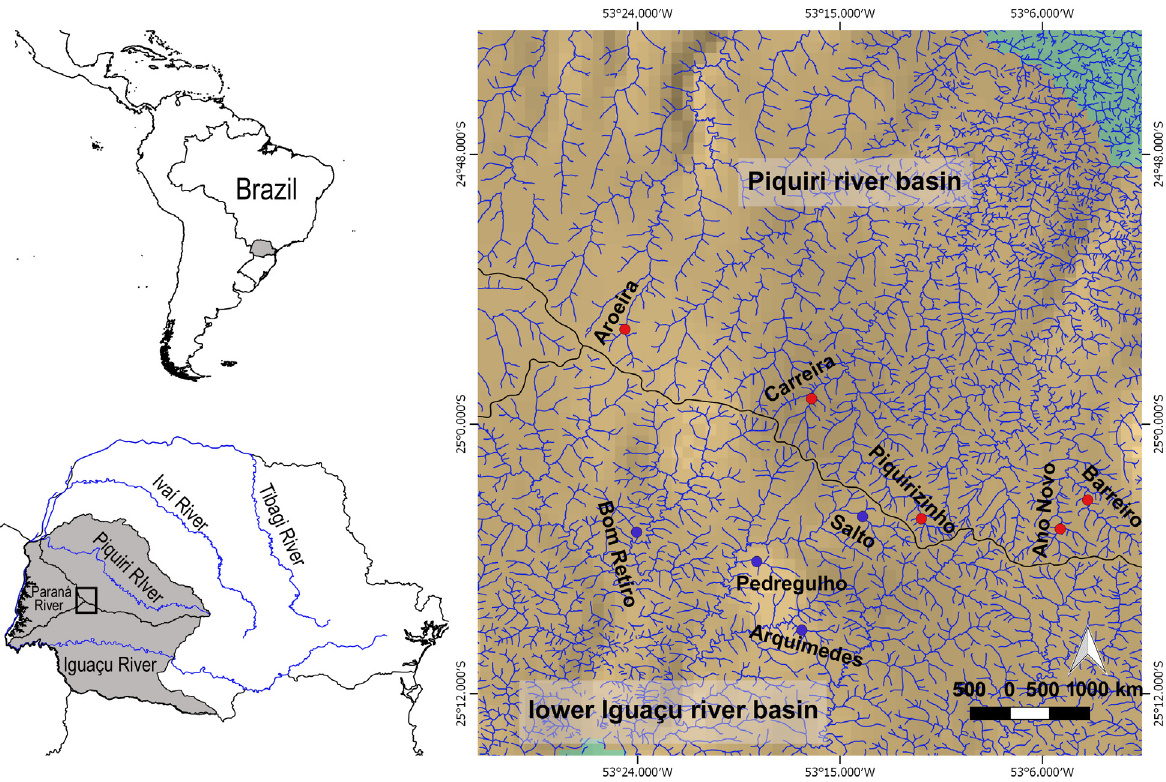
Figure 1. Distribution of Astyanax bifasciatus . Red circles are new records from the Piquiri river basin. Blue circles are records from the lower Iguaçu river basin. Black lines indicate the limits among Piquiri, lower Iguaçu, and Paraná III